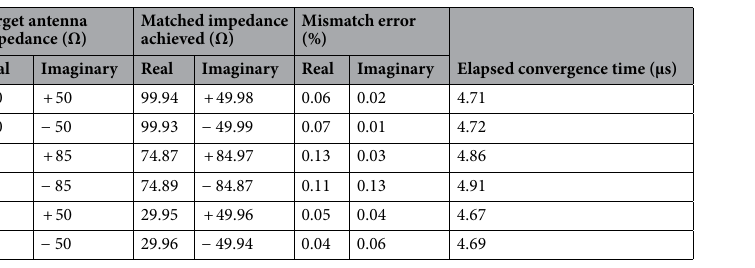
Table 1. Simulation results of target antenna impedance achieved.